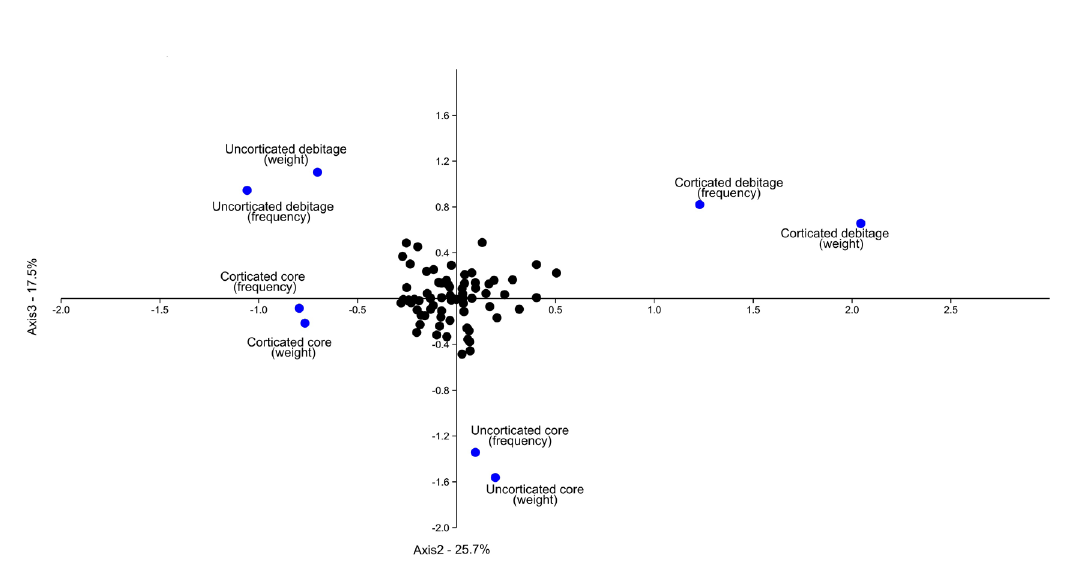
Figure 6: Correspondence analysis of Type 2 limnosilicite and the plot according to the second and third axis.